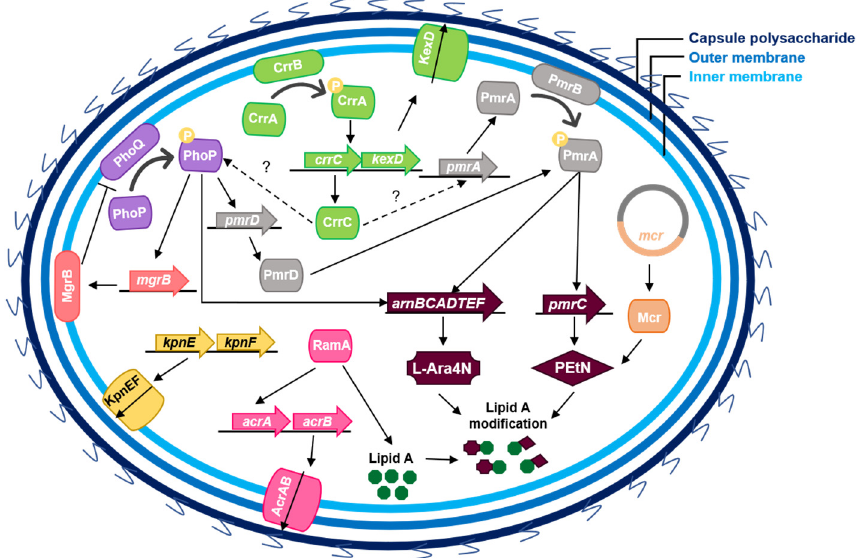
Figure 4. Gene regulatory and plasmid-encoding pathways of LPS modification in Klebsiella pneumoniae.